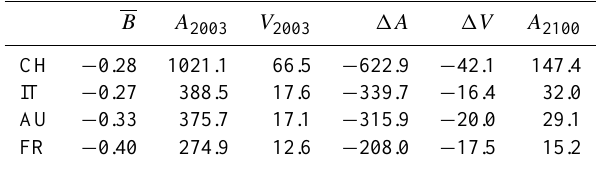
Table 4. Key values of glacier change over the 20th century for Switzerland (CH), Italy (IT), Austria (AU) and France (FR). B is the mean 1900–2011 mass balance in mw.e.a − 1 . Area A (in km 2 ) and estimated ice volume V (in km 3 ) are given for the year 2003, and area and volume changes ( 1A , 1V ) refer to the period 1900– 2011. A 2100 is the four RCP-average of modelled glacier area by